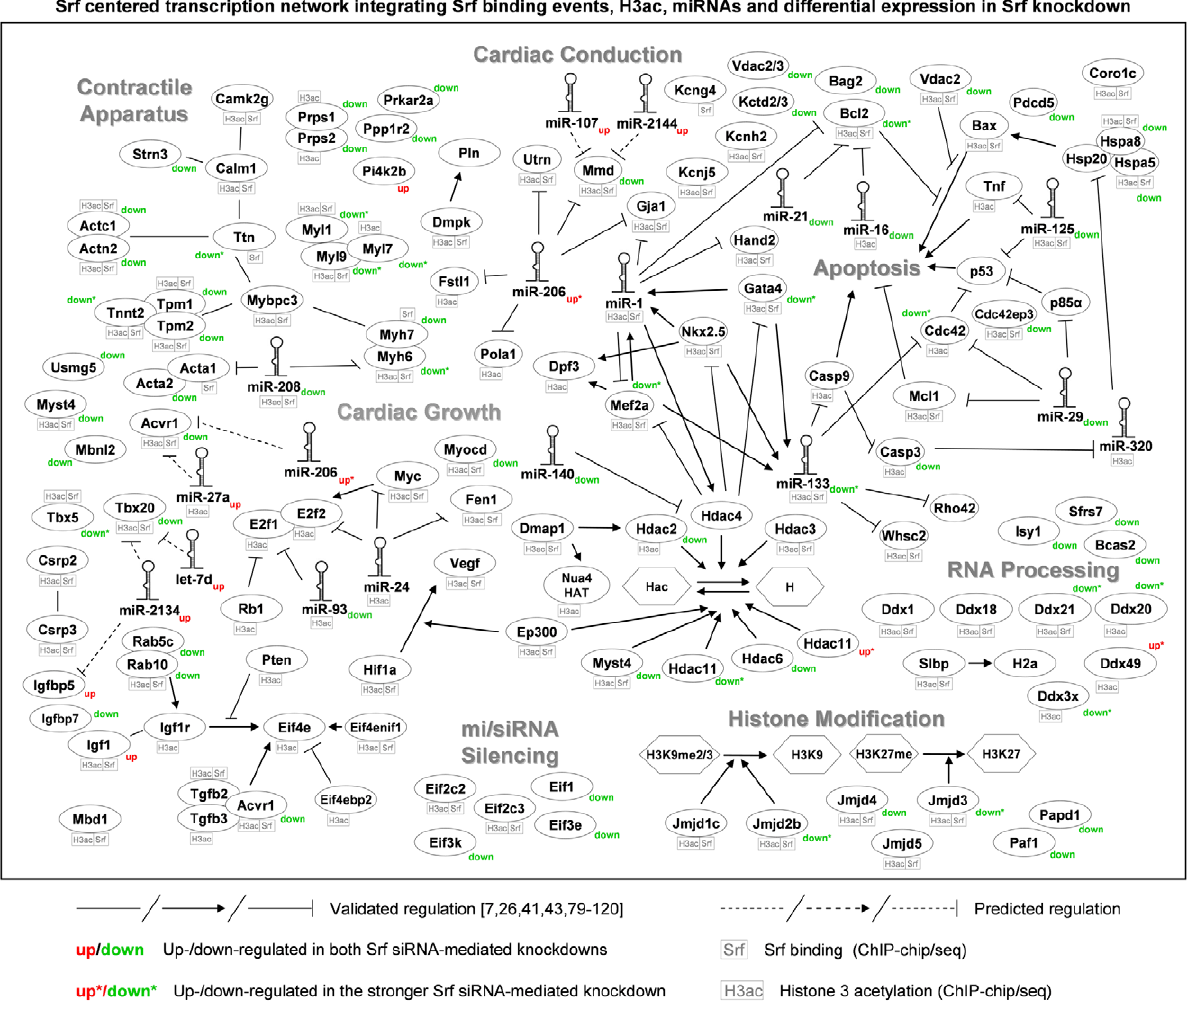
Figure 7. Srf-centered transcription network integrating Srf binding events, H3ac, miRNAs, and differential expression in Srf knockdown. The shown transcription network is based on an extensive literature search [7,26,41,43,79–120] and integration of our findings. Our data add the regulatory content to the nodes, which are connected by referenced interactions. It illustrates the common regulation by Srf and histone 3 acetylation (H3ac) as well as the impact of the posttranscriptional modulation of expression levels by miRNAs. Data based on Illumina expression array, ChIP-chip/seq, miRNA-seq and qPCR. Srf binding and H3ac occurrence are depicted in small boxes and up- (red) or downregulation (green) in Srf knockdown is further